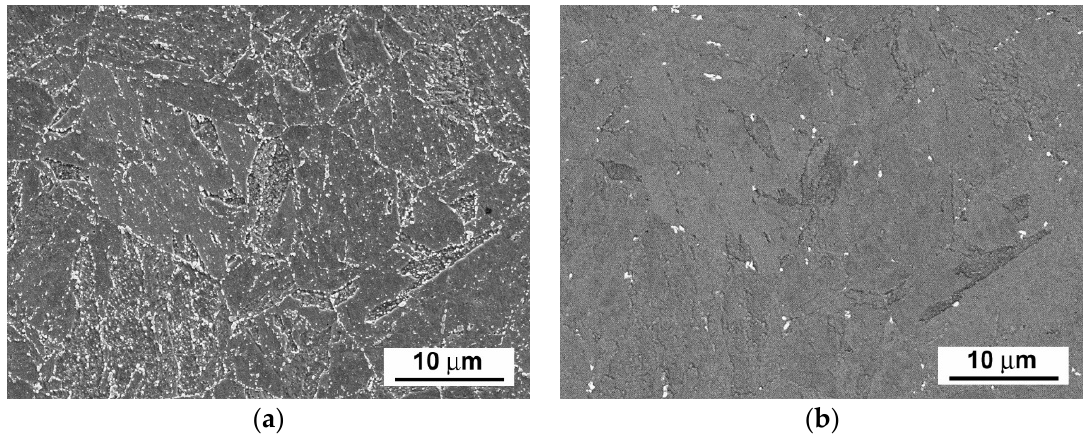
Figure 18. SEM microstructures of investigated P92 steel in thermally aged (600 °C/5 kh) and reju-